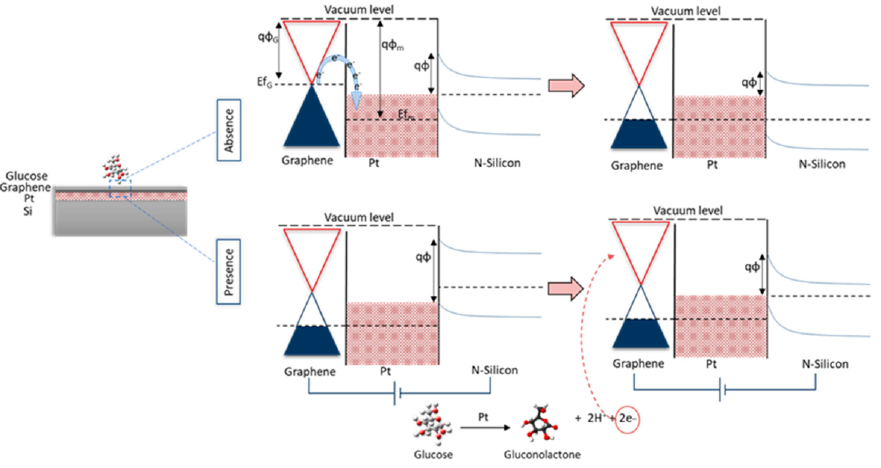
Figure 6. The working of the device explained by the band diagram